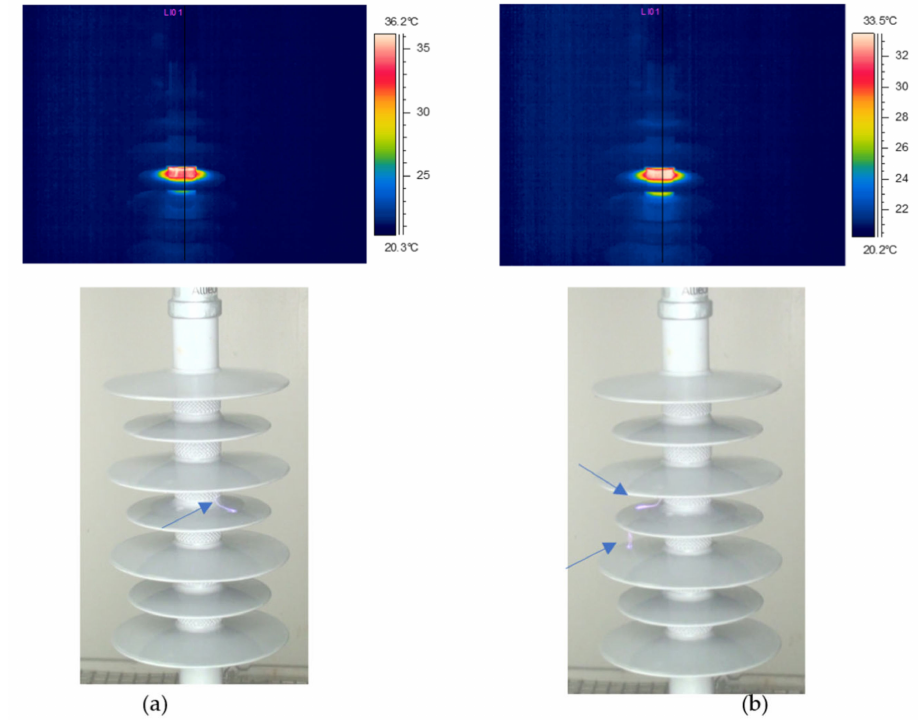
Figure 11. Dry Band Discharges (DbD) development for medium pollution. ( a , b ) represent DbDs activity and their corresponding IR